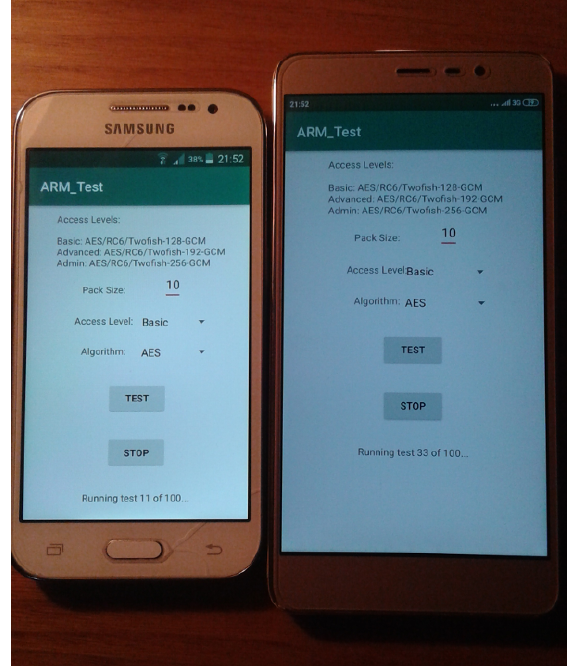
Figure 2. Devices used running the developed